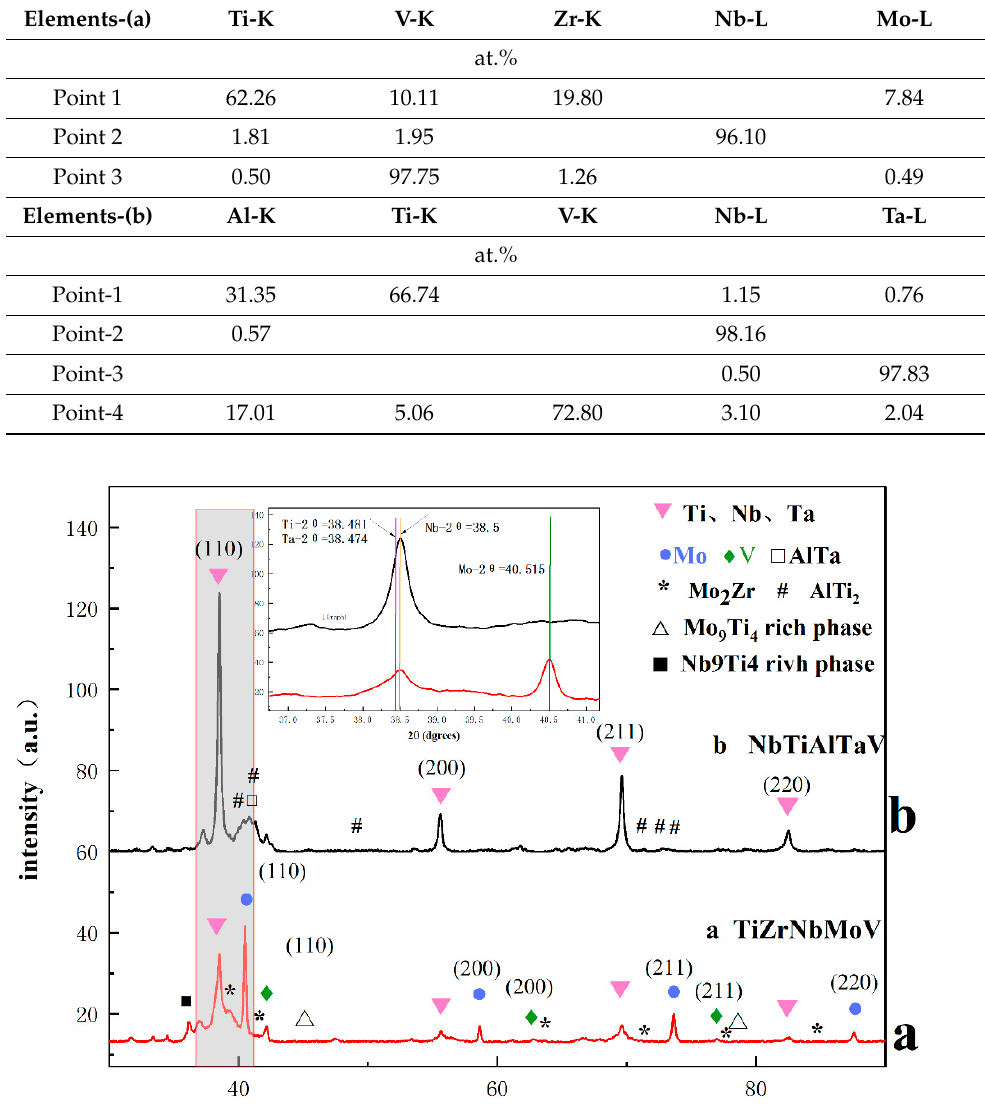
Table 2. Chemical composition of different points in TiZrNbMoV and NbTiAlTaV alloys.